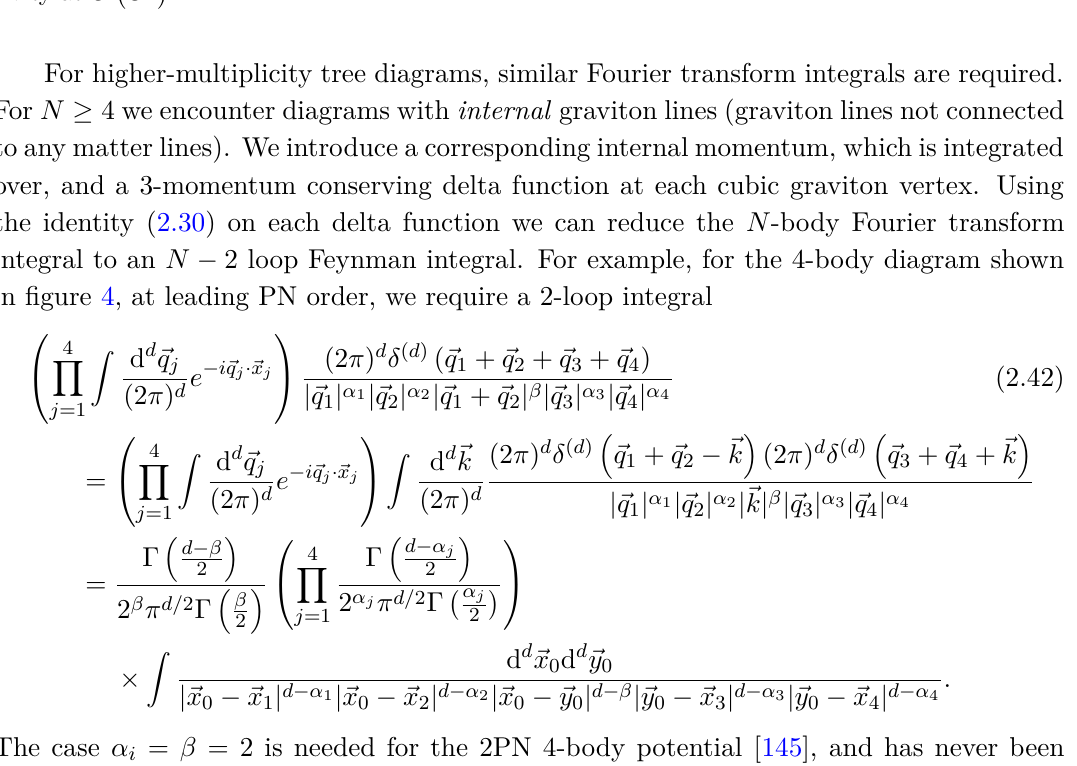
Figure 4 . Feynman diagram contributing to 4-body scattering of massive scalars in general rela- tivity at O (cid:0) G 3 (cid:1)